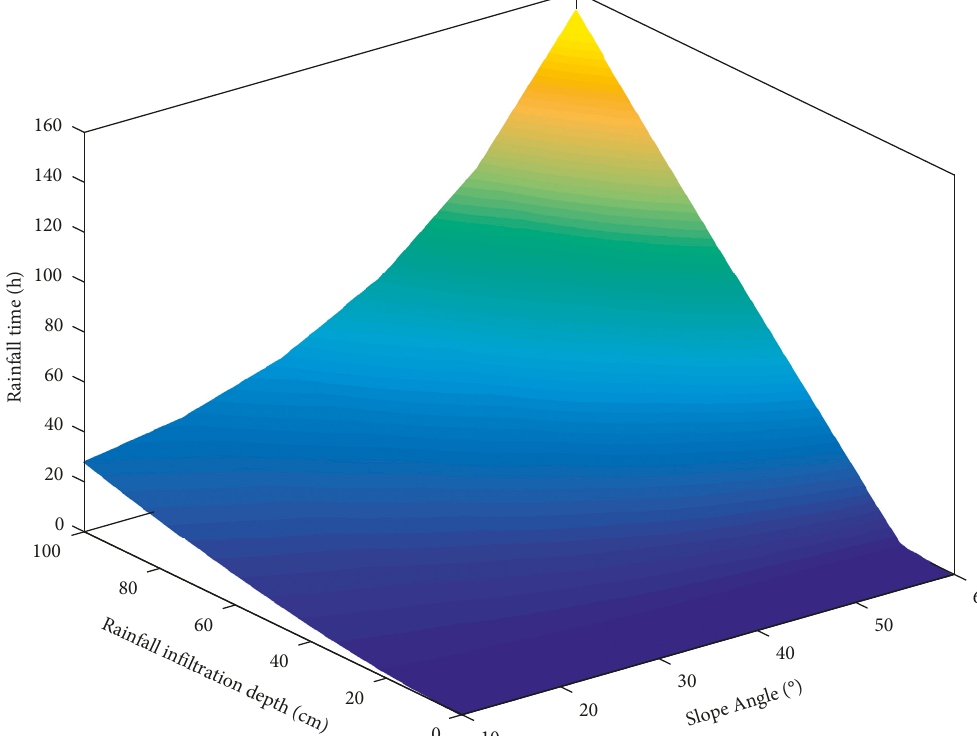
Figure 13: Variation of rainfall infiltration depth in the tailing slope with the changes of rainfall duration and slope